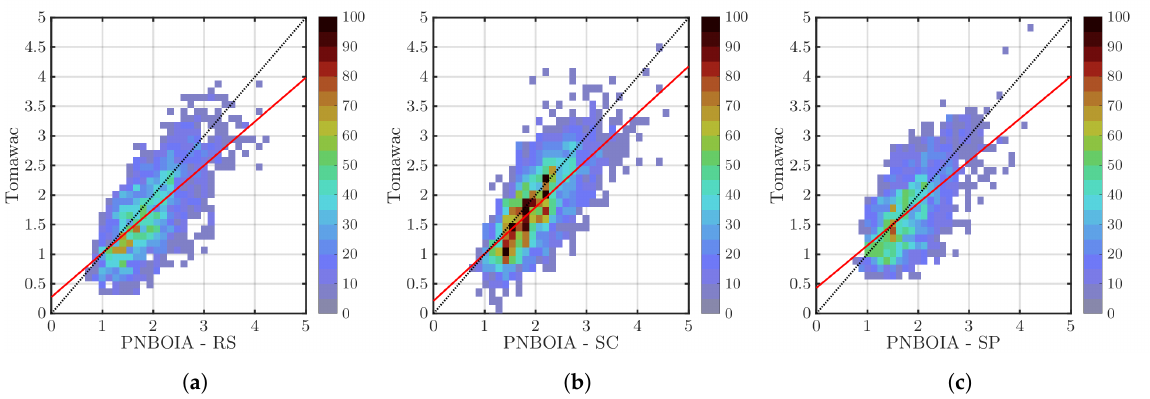
Figure 4. Scatter plots of the buoy data (horizontal axis) vs. T OMAWAC ’s result (vertical axis): ( a ) Rio Grande do Sul; ( b ) Santa Catarina; ( c ) São Paulo. The colour represents the number of data points in each bin. The solid line shows the linear regression of the data set and the dotted 45° line represents an ideal regression for